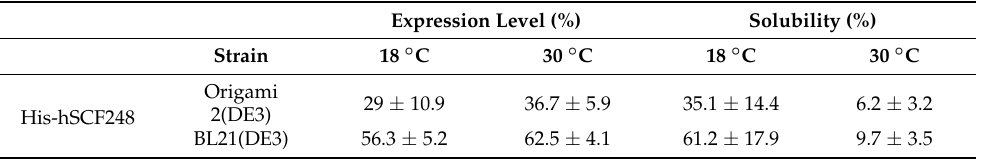
Table 2. Expression levels and solubilities of His-hSCF248 in Origami 2(DE3) and BL21(DE3) from triplicated